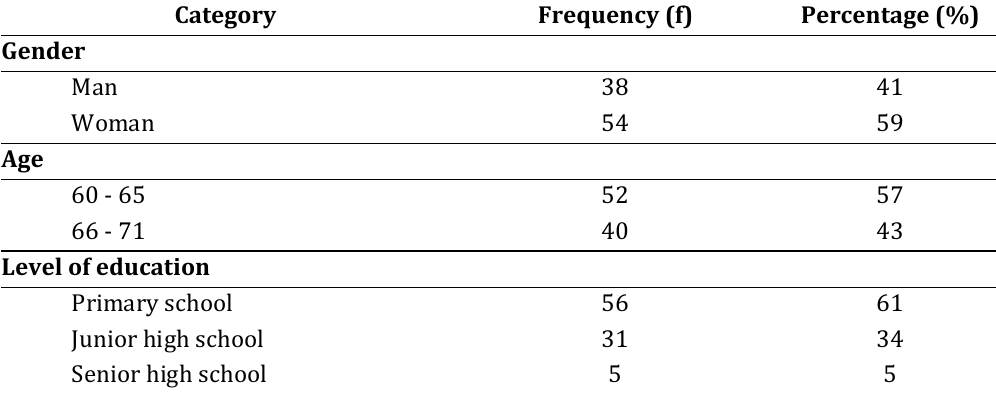
Frequency distribution and percentage of respondent characteristics